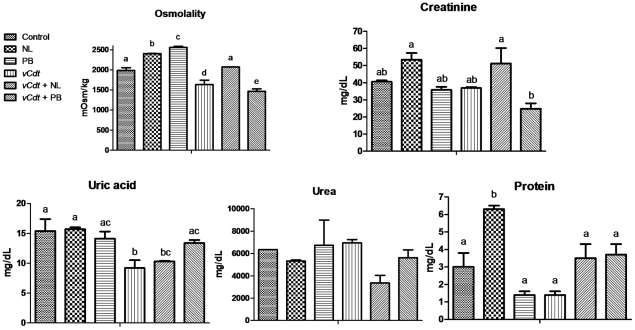
Effects of treatments on renal function parameters in the urine.Mice treated with vehicle (control), allopurinol (NL), probenecid (PB) and Crotalus durissus terrificus venom (vCdt) followed by NL (vCdt+NL) or PB (vCdt+PB) after 2 h. Values are means ± SEM of pooled animals, 16 (control), 9 (NL), 10 (PB), 12 (vCdt), 22 (vCdt+NL) and 12 (vCdt+PB) in triplicates. Comparison of the same parameter among groups: ANOVA (Osmolality, p<0.0001; Creatinine, p<0.0009; Uric acid, p<0.005; Urea, p = 0.06; Protein, p<0.001). Post hoc Student-Newman-Keuls (different letters over the bars indicate statistical differences: osmolality and creatinine, p<0.01; uric acid and protein, p<0.05).